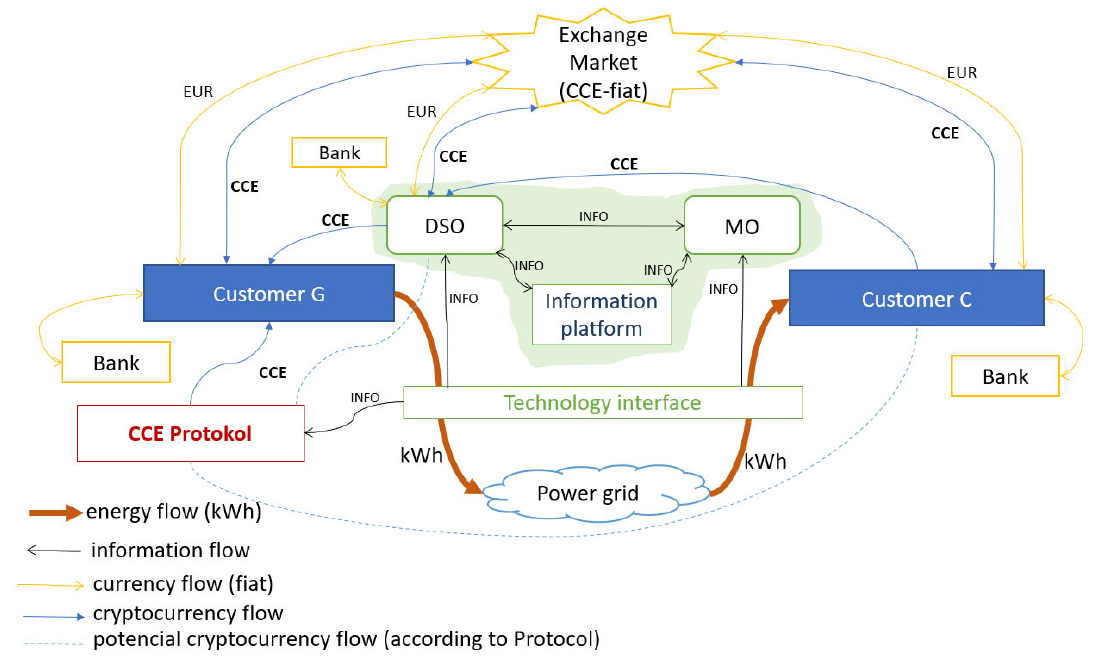
Figure 4. General functional diagram of a CCE ‐ based settlement system.